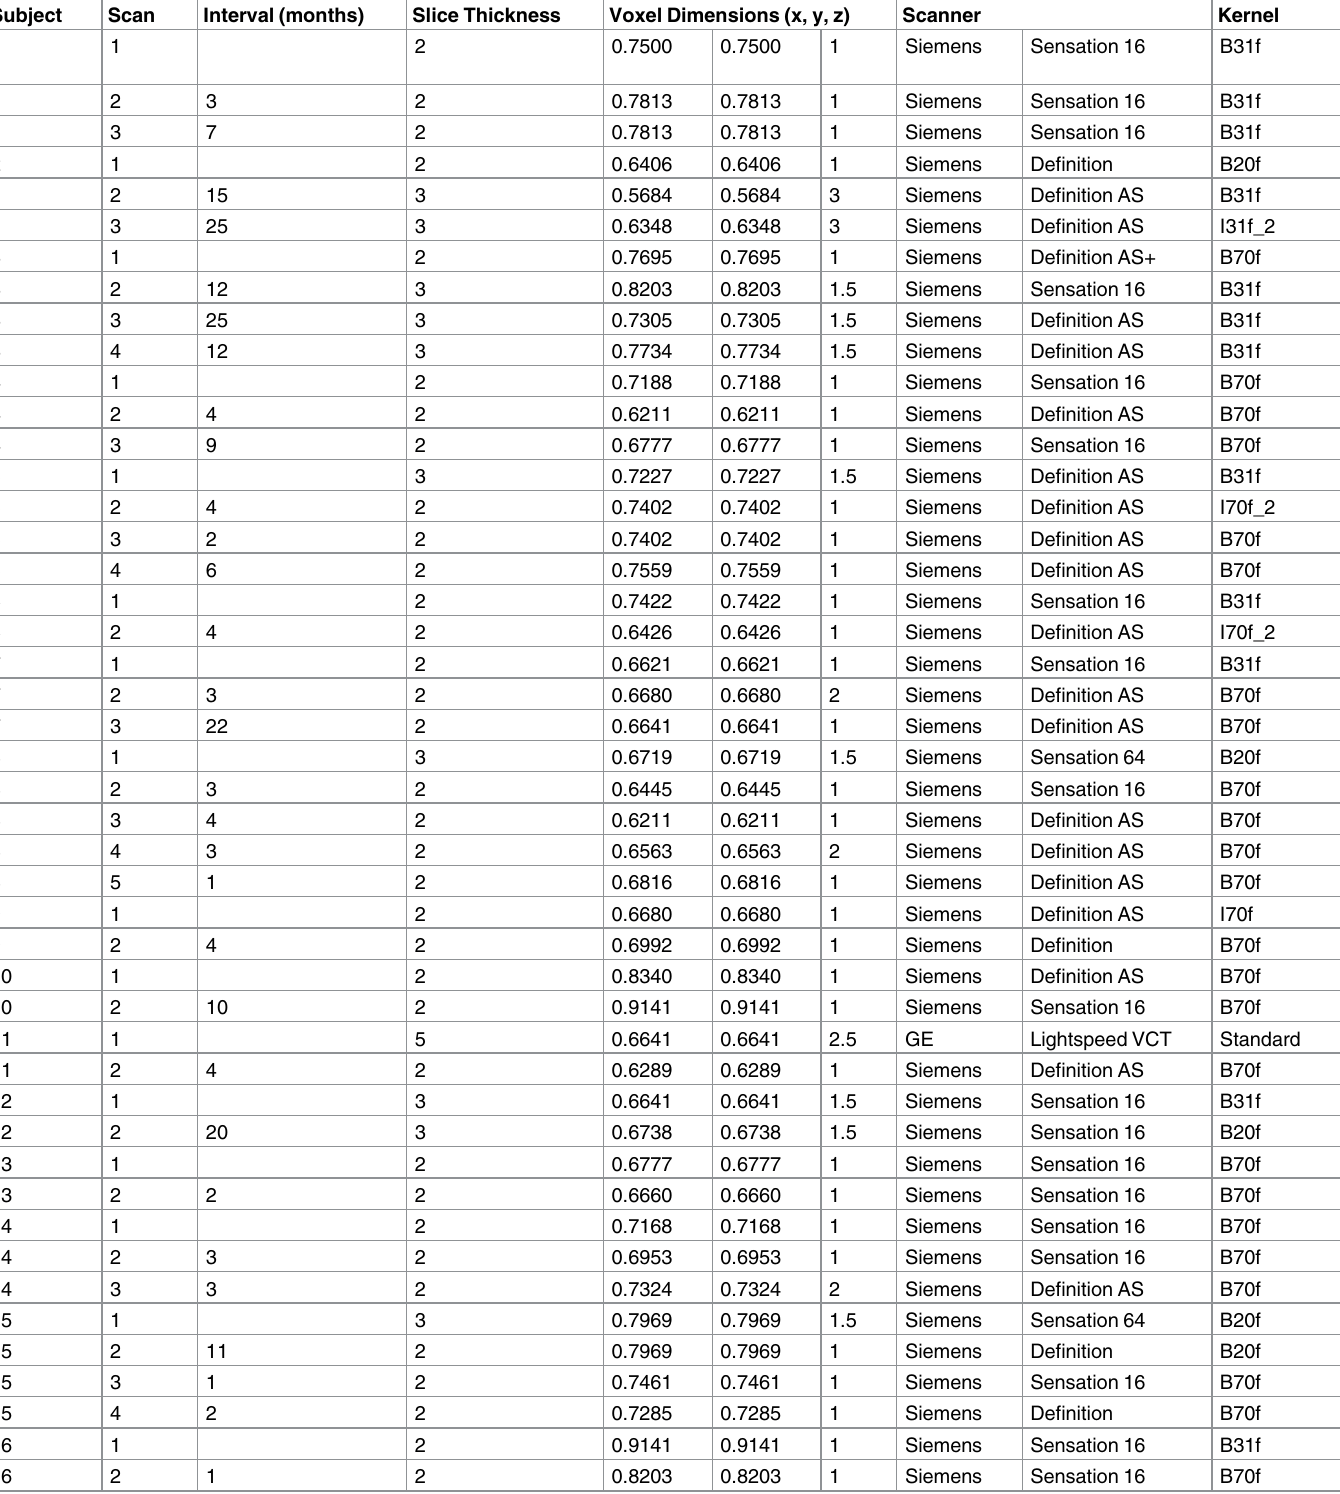
Table 2. CT scan information of Group 3